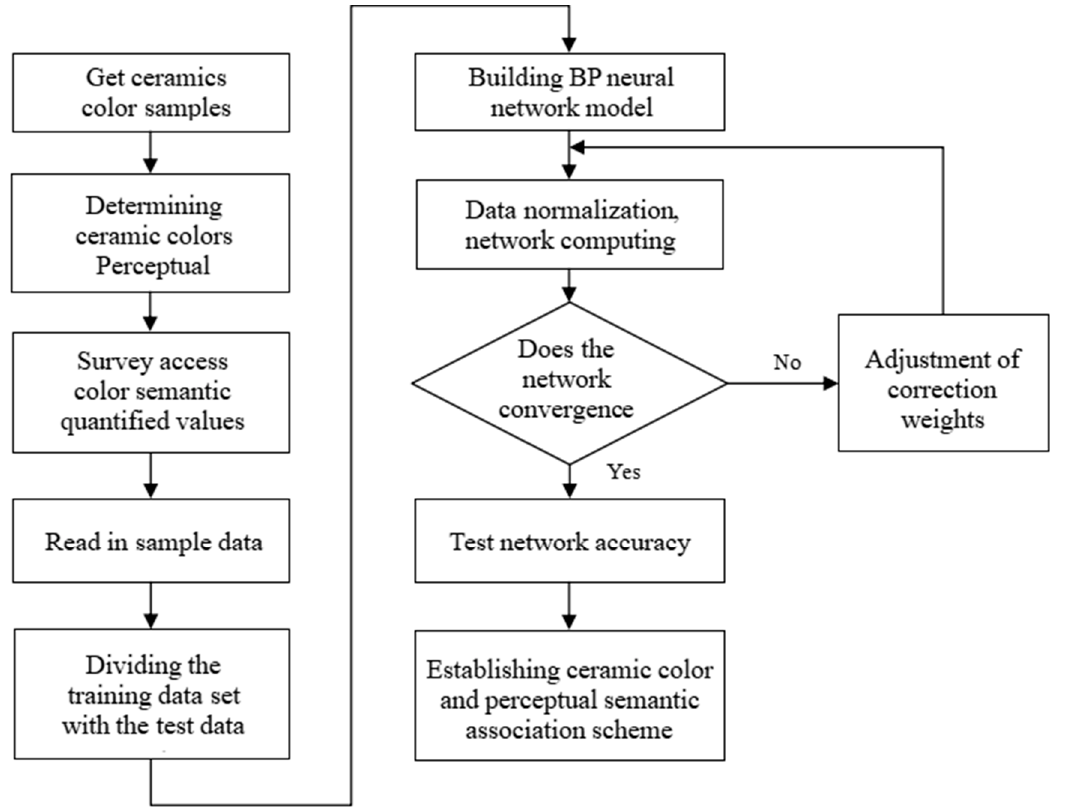
Figure 4. Flow chart of ceramic color semantic mapping model.